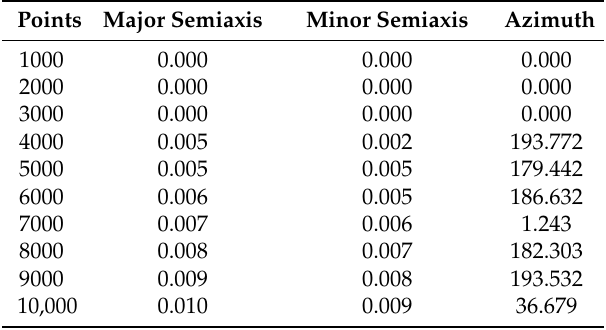
Table 3. Traverse adjustment (solution b): standard ellipses, values in metres and degrees. Points Major Semiaxis Minor Semiaxis Azimuth